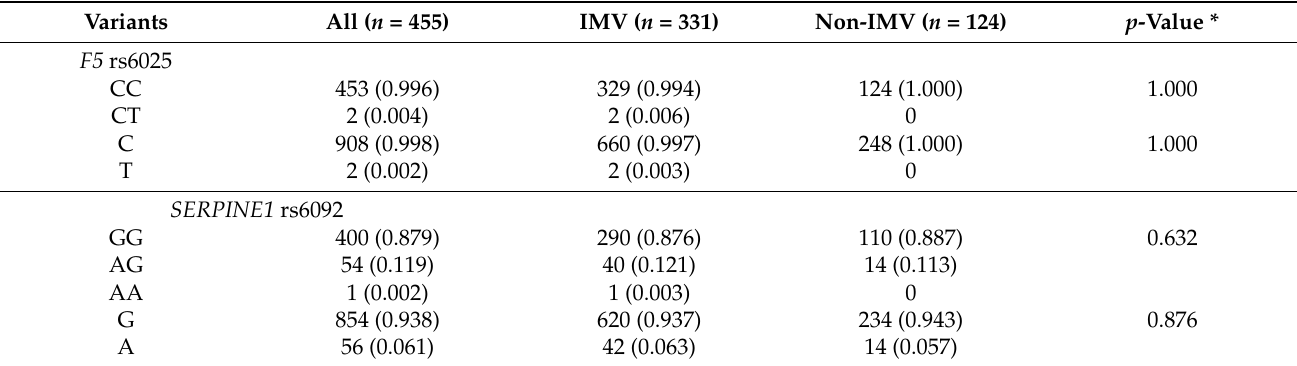
Table 3. Association study of genotype and allele frequencies of F5 rs6025 and SERPINE1 rs6092 among critical